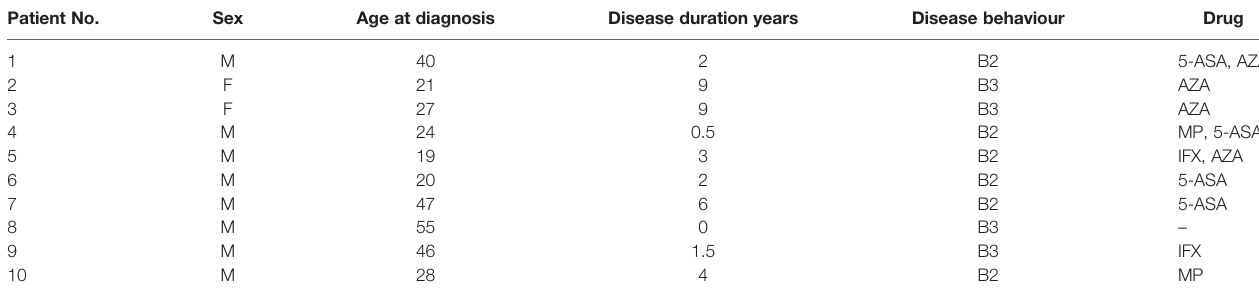
TABLE 2 | Characteristics of the 10 patients with CD included in the study. Patient No.